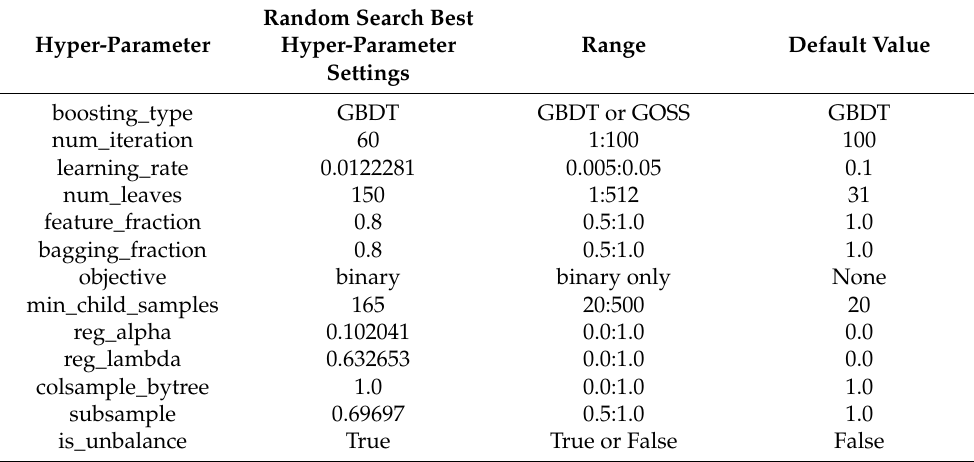
Table 4. LightGBM Random Search Hyper-parameter Results (Ember